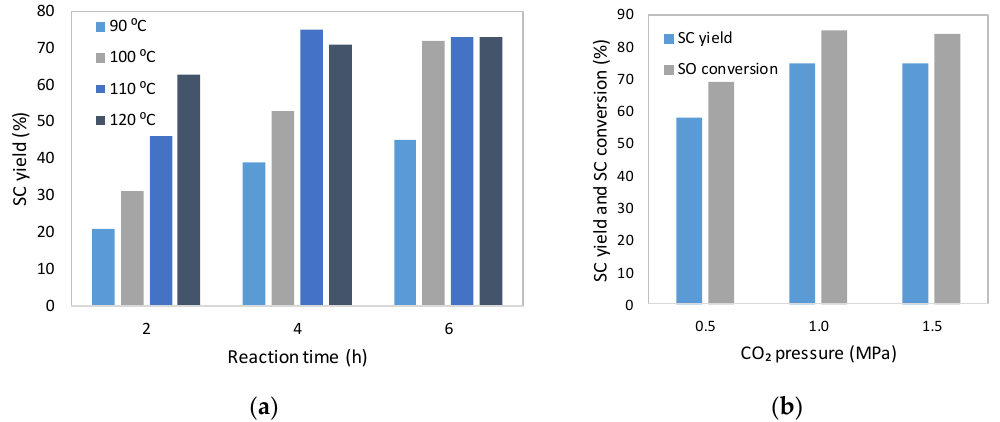
Figure 3. The effect of: ( a ) the temperature and reaction time; ( b ) CO 2 pressure; on the synthesis of styrene carbonate from CO 2 and styrene oxide. Reaction conditions: SO, 0.13 mol; [mtespim]Cl/@SiO 2 , 0.5 mol%; ZnBr 2 , 0.1 mol%; 700 rpm.